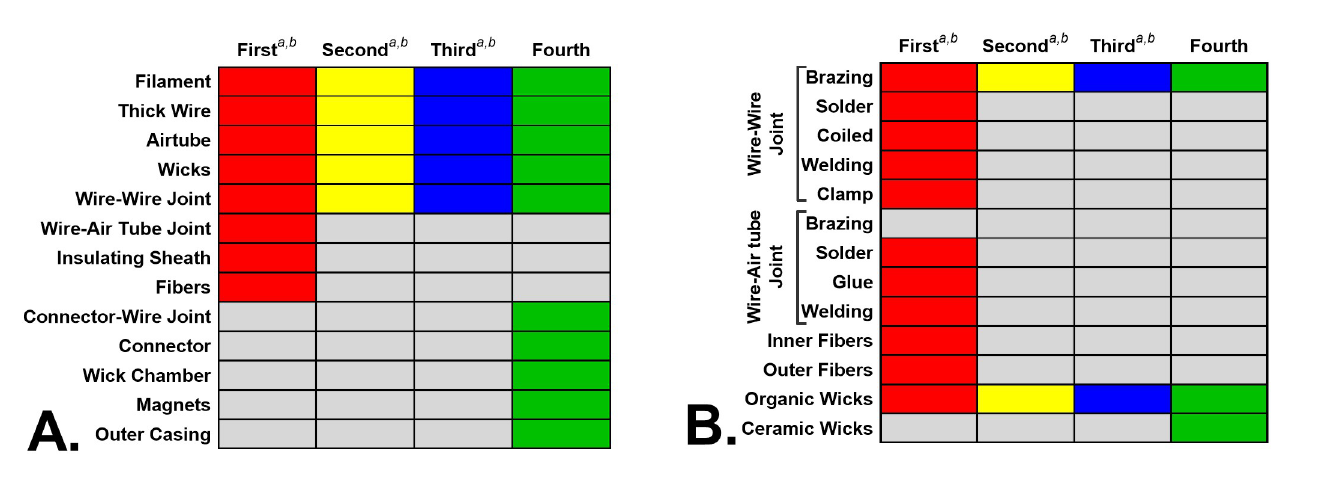
PLOS ONE | https://doi.org/10.1371/journal.pone.0248127 March 9,